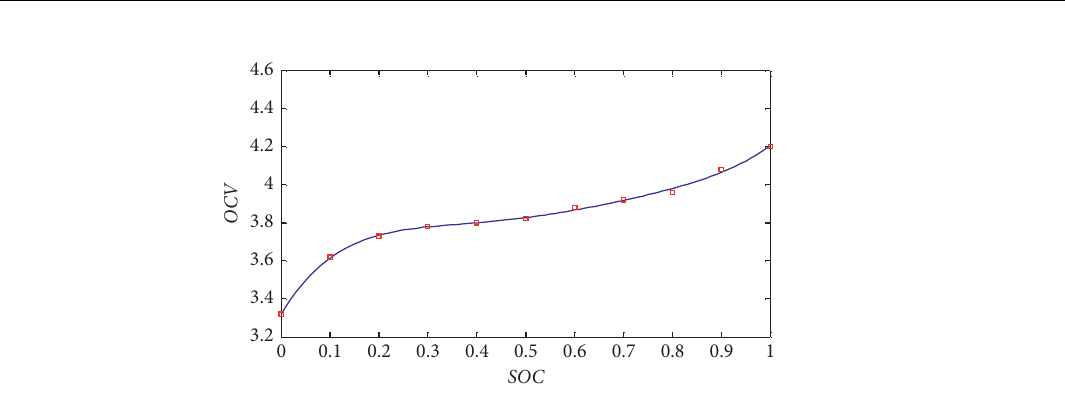
Figure 6: The relationship between SOC and OCV in lithium